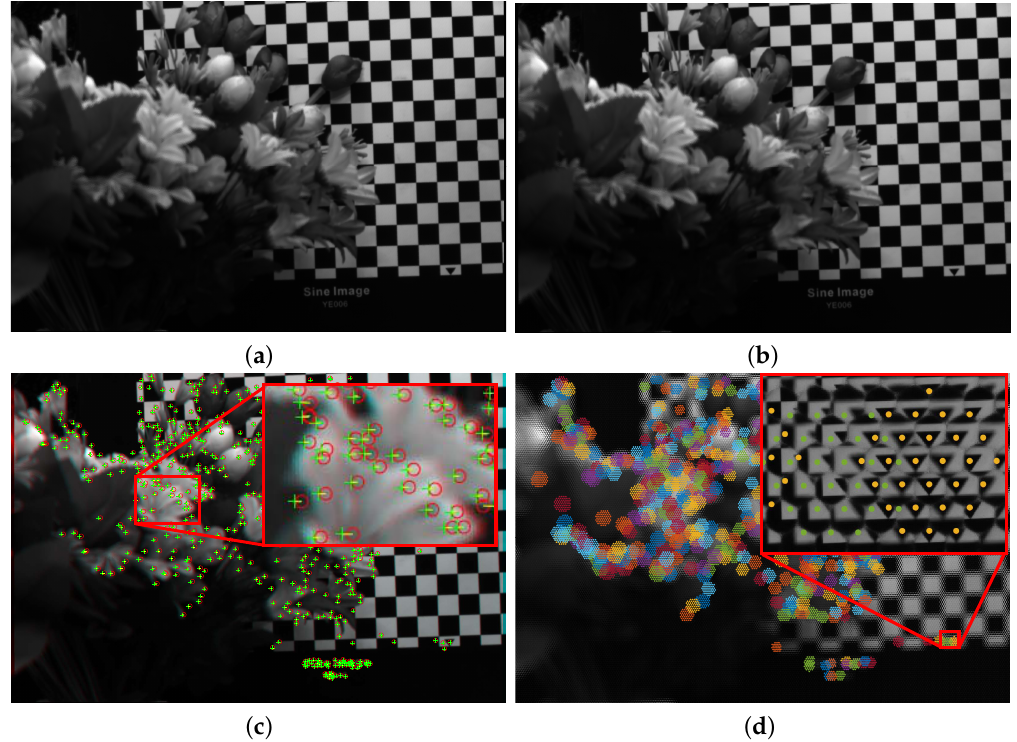
Figure 14. Example of feature detection on real data. ( a ) Left refocused image. ( b ) Right refocused image. ( c ) Feature matching result of central projection stereo refocused image pair. ( d ) Illustration of detected features on raw